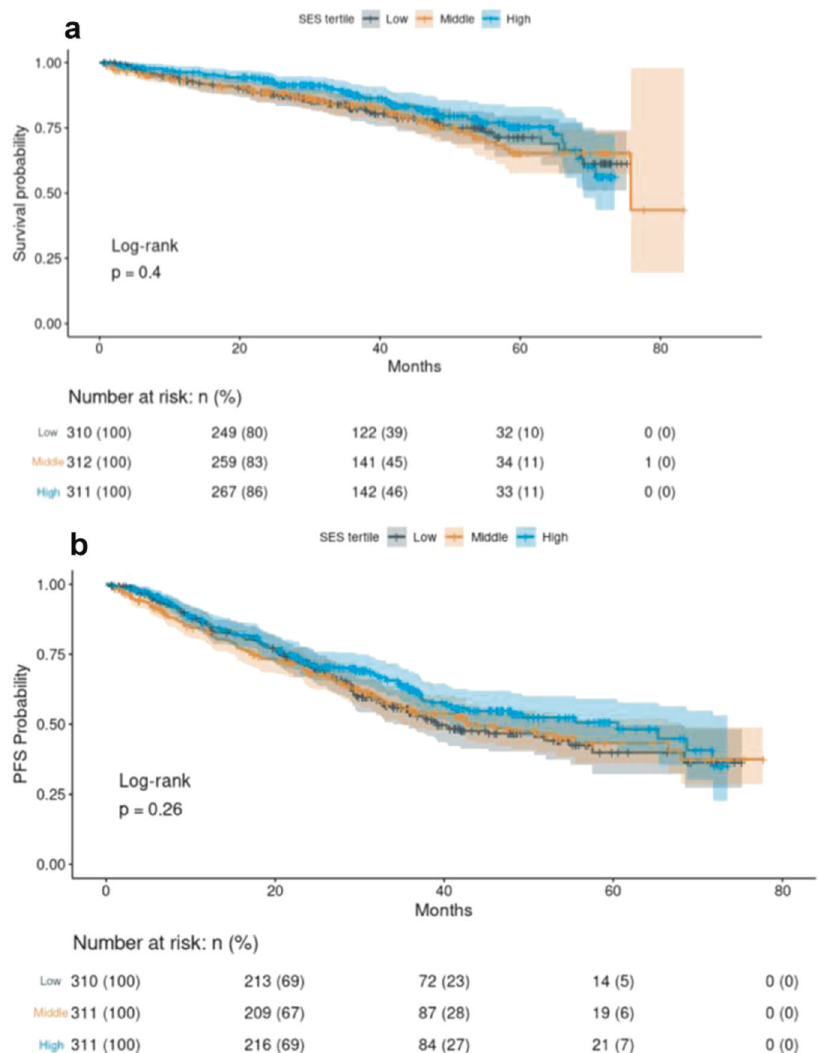
Fig. 2 Evaluation of overall survival and progression-free survival by nSES. a Overall survival by nSES. b Progression-free survival by